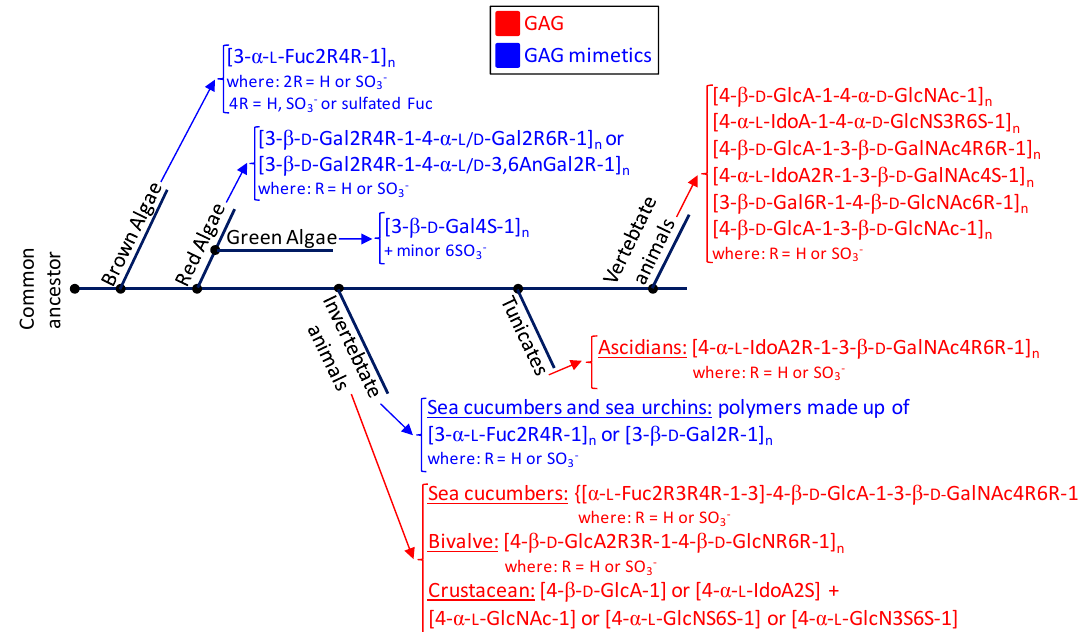
Figure 6. Phylogenetic relationship of glycosaminoglycans (GAGs) (red) and mimetics (blue) of seaweeds (brown, red and green algae), marine invertebrate animals, marine tunicates and vertebrate animals (from marine or terrestrial environments). The structural abbreviations are S for sulfation, R for radical, Fuc for fucose, Gal for galactose, GlcA for glucuronic acid, GlcNAc for N -acetylglucosamine, GalNAc for N -acetylgalactosamine, IdoA for iduronic acid and GlcN for glucosamine. R and S stand for radicals and sulfation, respectively. The major goal for showing this simplified scheme is to just illustrate the principal structures of the sulfated glycans expressed in the classes of organisms discussed herein and not the accurate evolutionary relationship between the cited organisms in terms of sulfated glycan-related genotypes or phenotypes or through the evolution history. Conflicts of Interest: The authors declare no conflict of